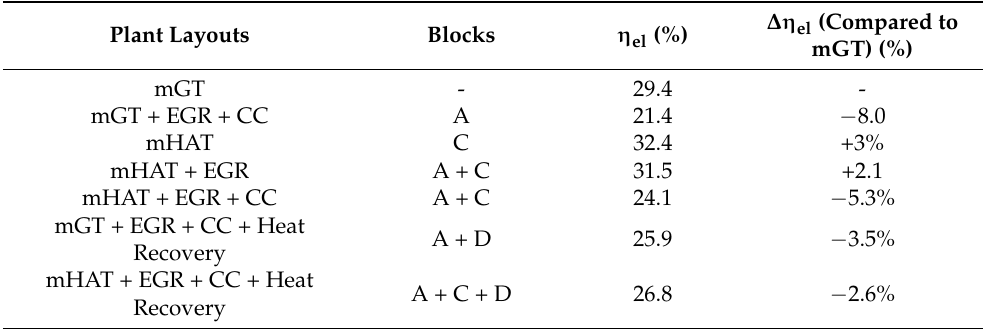
Table 9. Comparison of the electrical efficiencies for different plant layouts where there is no heat demand (adapted from